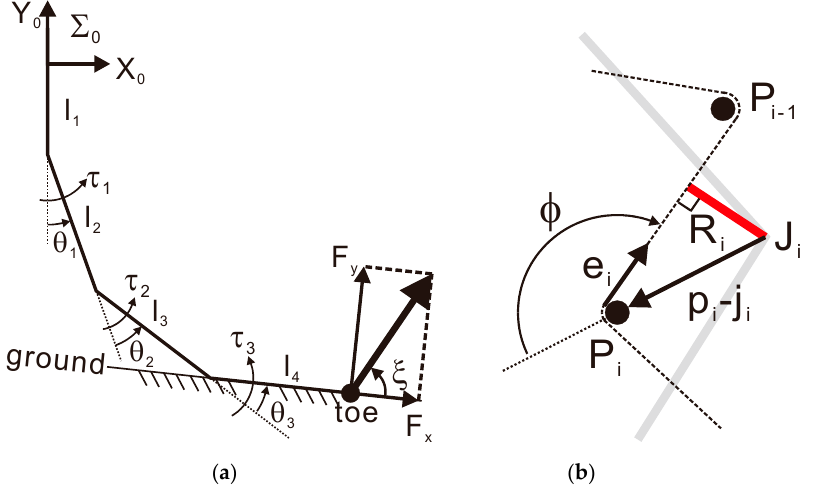
Figure 2. Mathematical model. ( a ) Posture and force; ( b ) Distance R i .